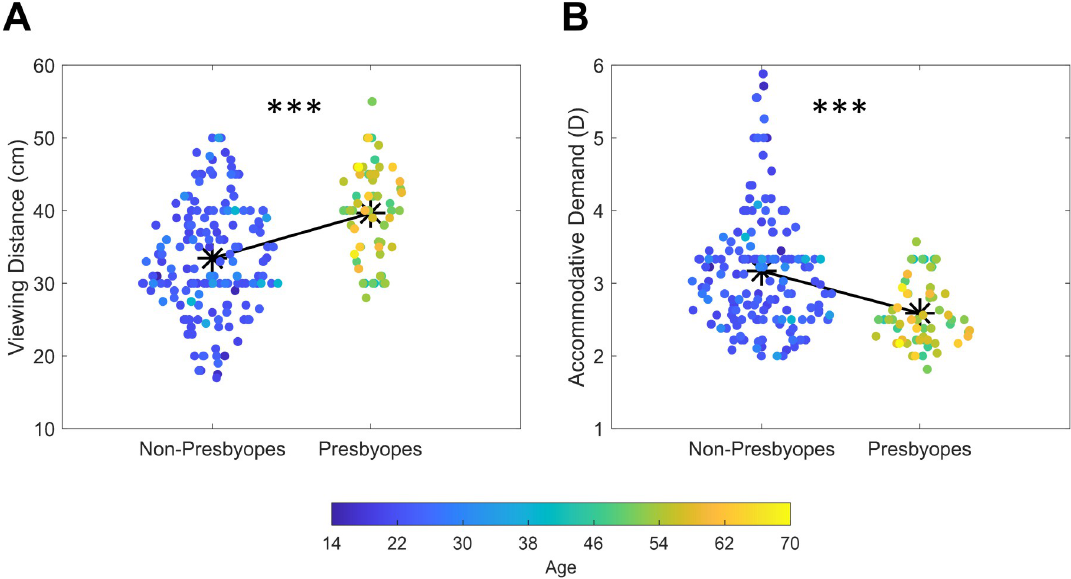
Fig 2. Scatterplot depicting values of reading distance (A) and accommodative demand (B) for non-presbyopes and presbyopes. Asterisks depicts average values while different colors represent different ages ( ��� = p < 0.001).